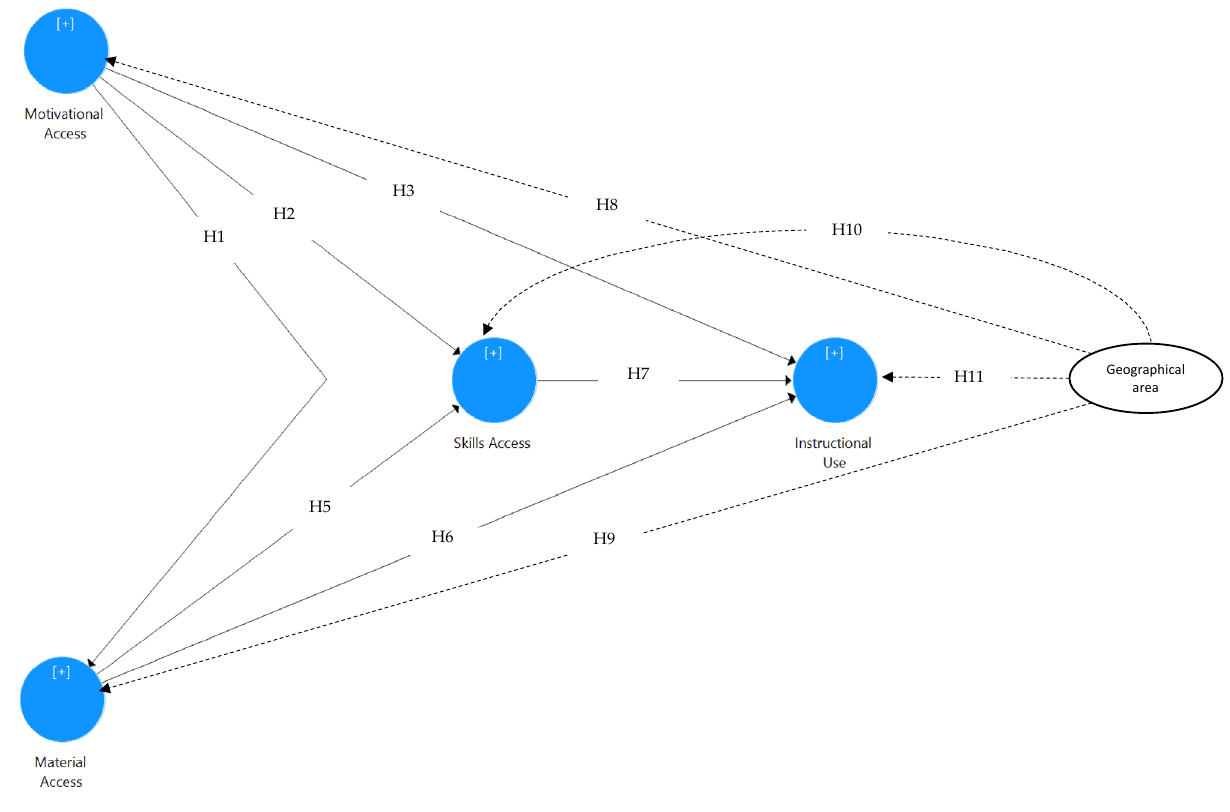
Figure 1. Proposed